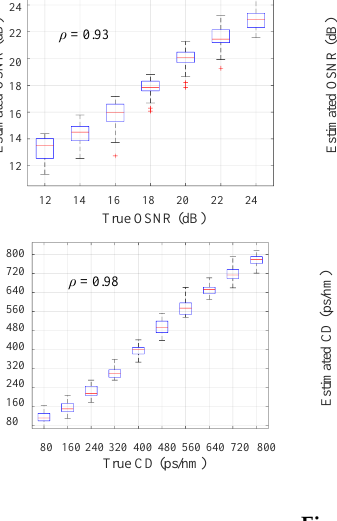
Figure 8. OPM results using AAH (1st column and 3rd column ) and IQH (2nd column and 4th column) with SVR for side (1st column and 2nd column) and middle (3rd column and 4th column) sub-carriers ( a ) OSNR and ( b )